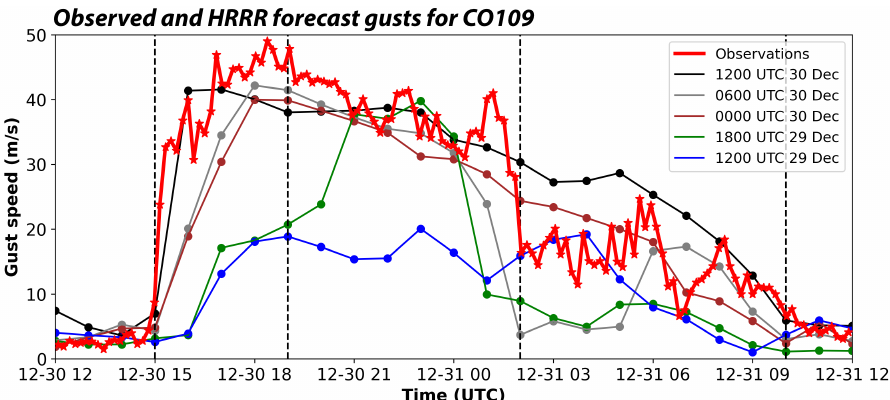
Figure 6. Observed gusts (red, m/s) at station CO109 (see Figure 1 for location). Also shown are HRRR forecasts of gust potential from cycles as identified in legend. Forecasts drawn from top-of-hour model